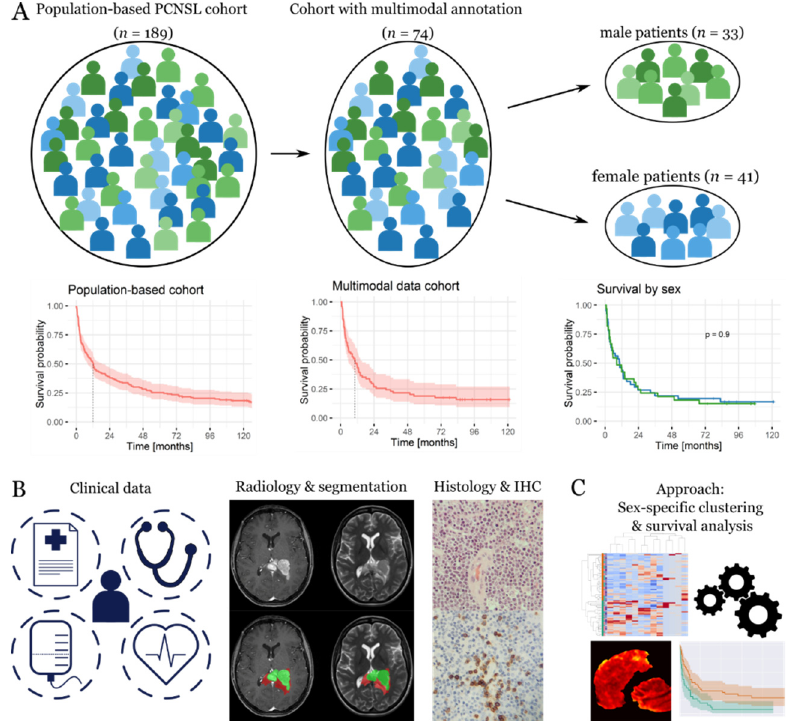
Figure 1. Population-representative cohort with dense phenotypic annotation. ( A ) Starting from a population-based cohort ( n = 189), we retrieved dense phenotypic annotation for a sub-cohort of patients ( n = 74) representative of the underlying population in terms of outcome. The dataset was split into female ( n = 41) and male ( n = 33) patients for a further sex-specific analysis. ( B ) The latter was based on clinical and therapeutic data; magnetic resonance imaging data, including tumor segmentations; and digital pathology data, including immune scores. magnification: ×20. ( C ) The data were integrated using cluster and survival analyses in a sex-specific manner.